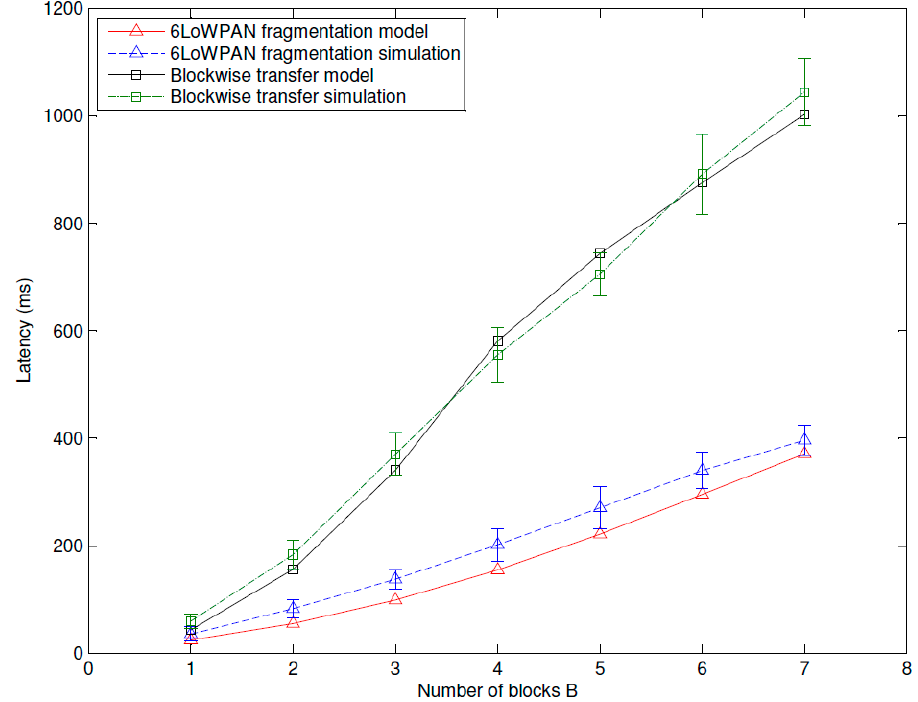
Figure 20. Blockwise and 6LoWPAN latency vs. the number of blocks or fragments for a star topology network composed by 20 nodes and a traffic rate of 1